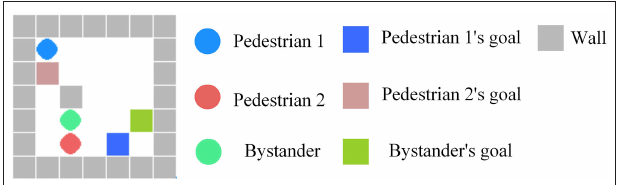
FIGURE 5 | An example of a random environment. The environment consists of three agents: a bystander and two pedestrians. Different agents have different goals to reach. Agents cannot pass through